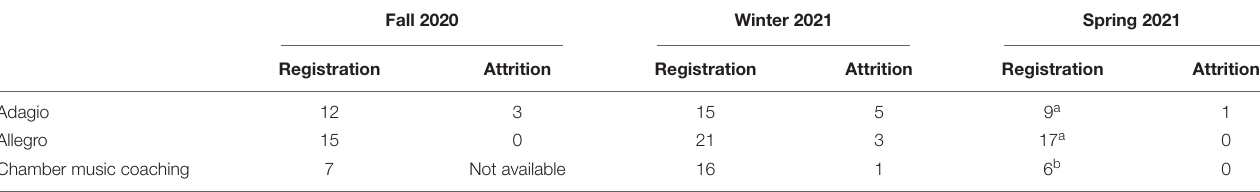
TABLE 1 | Registration and attrition per online